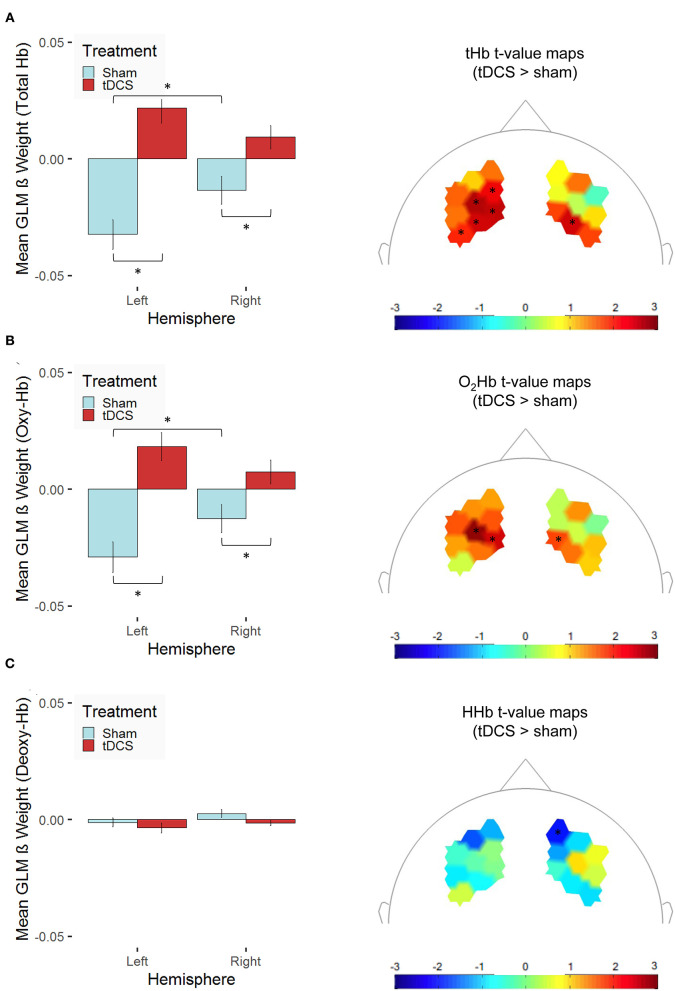
Stimulation-dependent modulation of hemodynamic concentration changes in the dorsolateral prefrontal cortex is shown for (A) total hemoglobin (tHb), (B) oxygenated hemoglobin (O2Hb/Oxy-Hb), and (C) deoxygenated hemoglobin (HHb/Deoxy-Hb). The left panel indicates mean β values [error bars indicate 1 standard error (SE) of the mean, *p < 0.05 for post-hoc multiple comparisons after Holm correction] across the channels of the two hemispheres (left vs. right) averaged across both experimental conditions for participants, who received bilateral active transcranial direct current stimulation (tDCS; red) compared with sham stimulation (sham; blue). The right panel presents t-value maps depicting the contrast between the two treatment groups (tDCS > sham stimulation), unthresholded (* indicates thresholded t values with p < 0.05 before correcting for multiple testing; none of these values survives Holm correction).